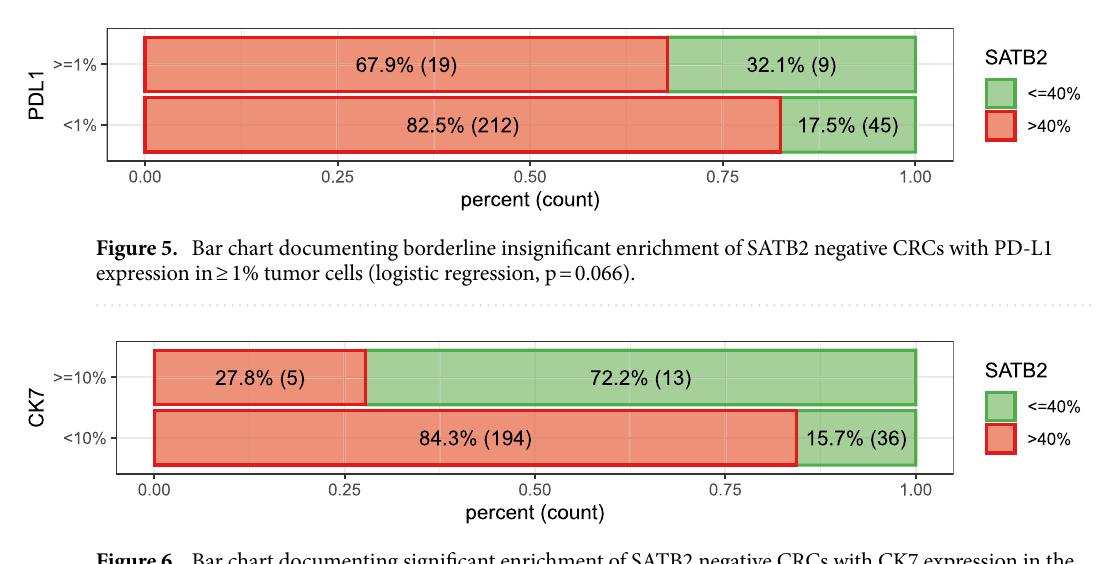
Figure 6. Bar chart documenting significant enrichment of SATB2 negative CRCs with CK7 expression in the neoadjuvant therapy-naïve cohort (logistic regression, p <